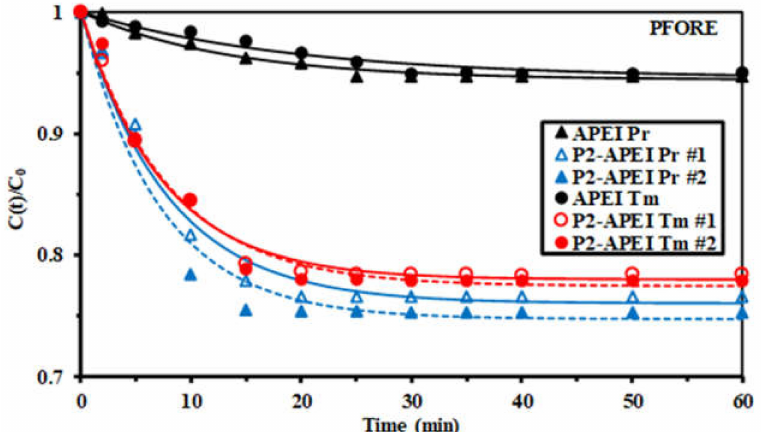
Figure 5. Pr(III) and Tm(III) uptake kinetics using APEI and P2-APEI sorbents (duplicate experiments) (C 0 : 50 mg L − 1 ; Sorbent dosage, SD: 0.25 g L − 1 ; pH 0 : 5; pH eq : 4.87 and 4.62 for APEI for Pr(III) and Tm(III), respectively; 3.24–3.12 for Pr(III) and 3.44–3.47 for Tm(III) with P2-APEI; T: 22 ± 1 ◦ C; solid lines: modeling with PFORE).